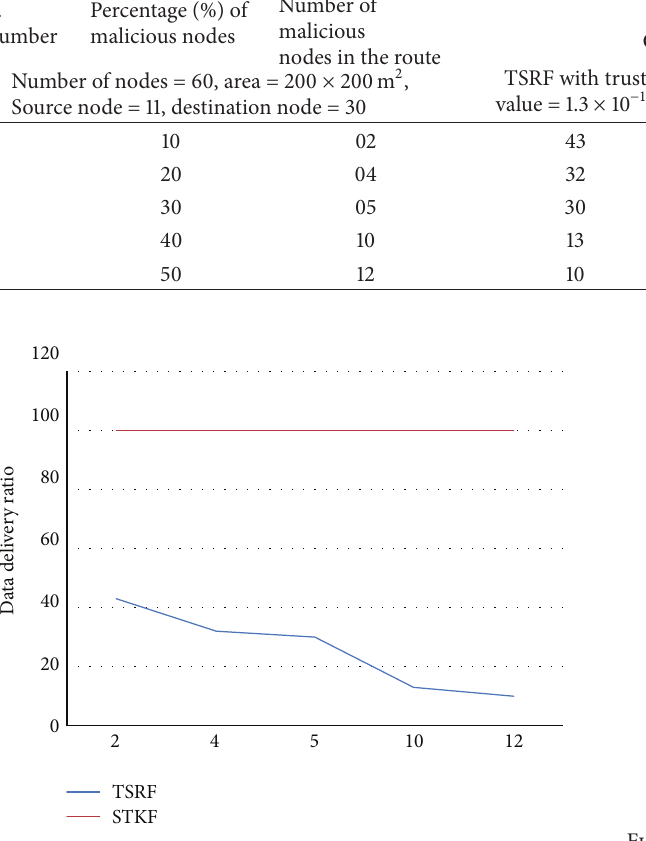
Figure 7: A graph between data delivery ratio and number of malicious nodes in the route (TSRF with trust value = 1.3 × 10 −11 & STKF with trust value = 1.4 × 10 −07 ).